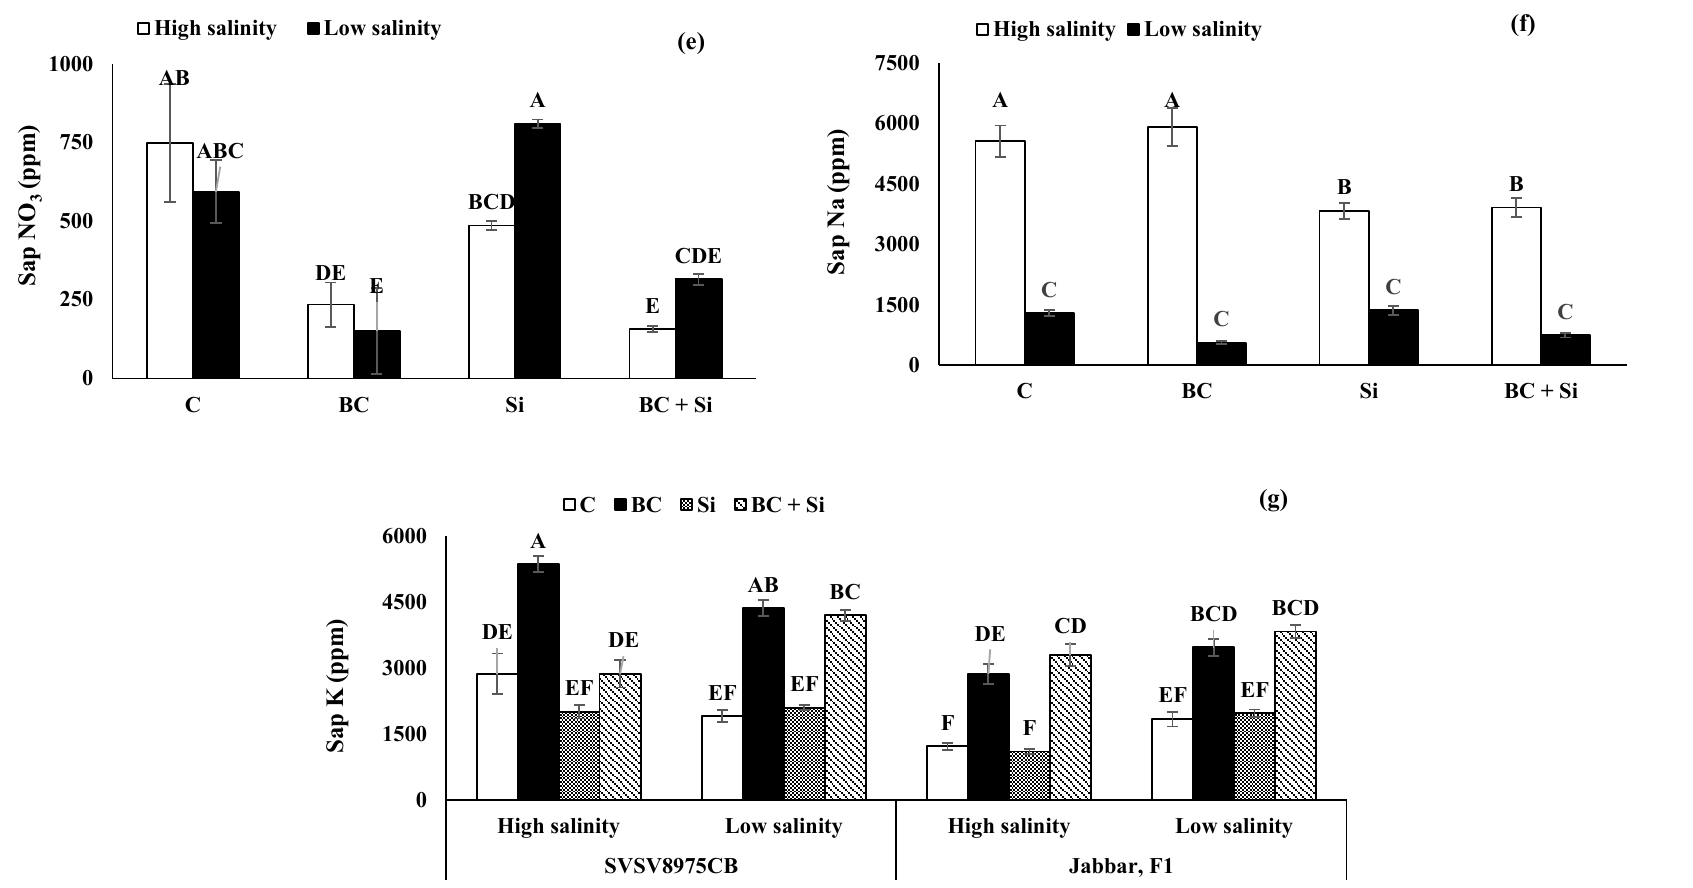
Figure 3. Influence of cultivar (C), soil type (S), and soil amendment (SA) interactions on morphology and sap nutrient concentration of cucumber. Comparison of C × SA interaction for ( a ) plant height; C × S × SA interaction for ( b ) leaf count; S × SA interaction for ( c ) plant fresh weight, ( d ) plant dry weight, ( e ) sap NO 3 concentration, and ( f ) sap Na concentration; C × S × SA interaction for ( g ) sap K concentration ± S.E. C = control; BC = biochar; Si = silica; BC + Si = biochar + silica. Means sharing the same letters do not differ significantly at p < 0.05.